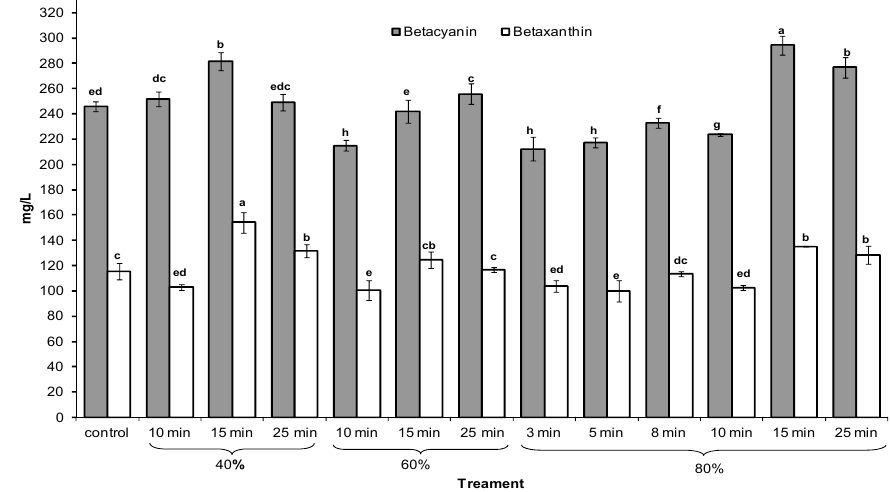
Figure 1. Betacyanins (mg betanin equivalent (BE)/L) and betaxanthins (mg indicaxanthin equivalent (IE)/L) content in purple cactus pear juices treated at different ultrasound conditions. a–h different letters in the same bar indicate significant differences ( p < 0.05).